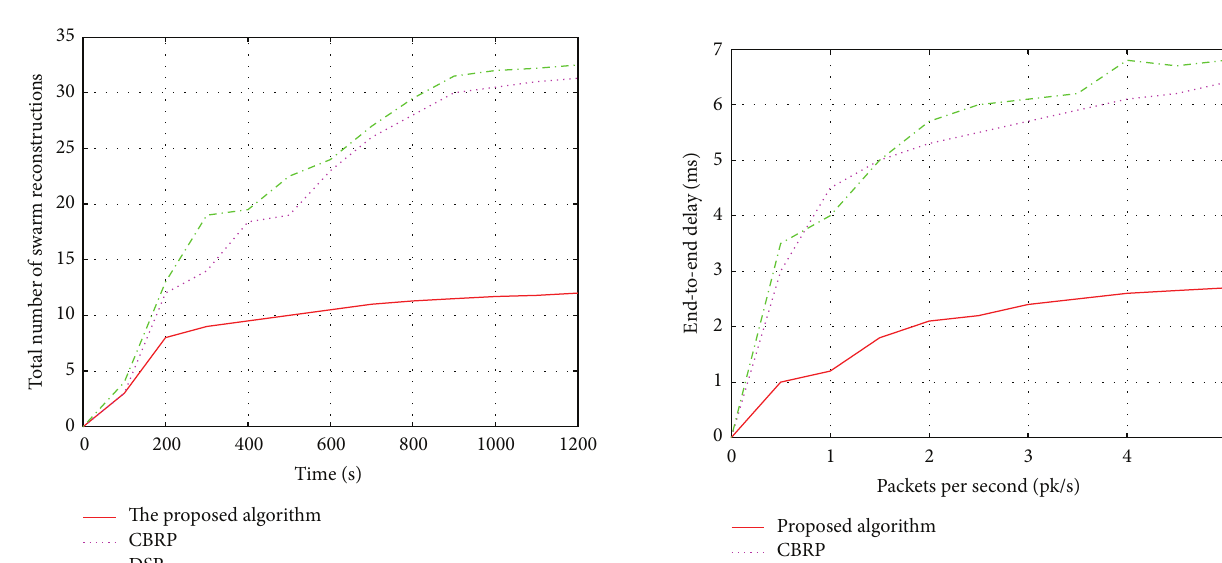
Figure 7: The PDR of the DSR, CBRP, and proposed algorithms.